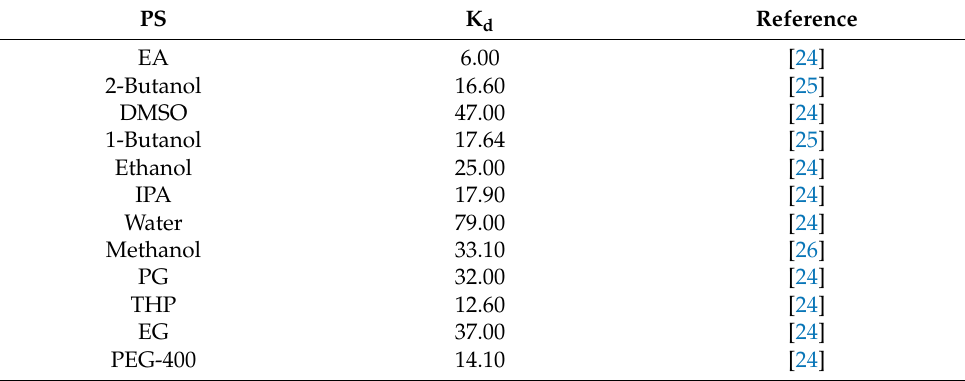
Table 2. The literature values of dielectric constants (K d ) for different PS at T = 298.2 K. PS